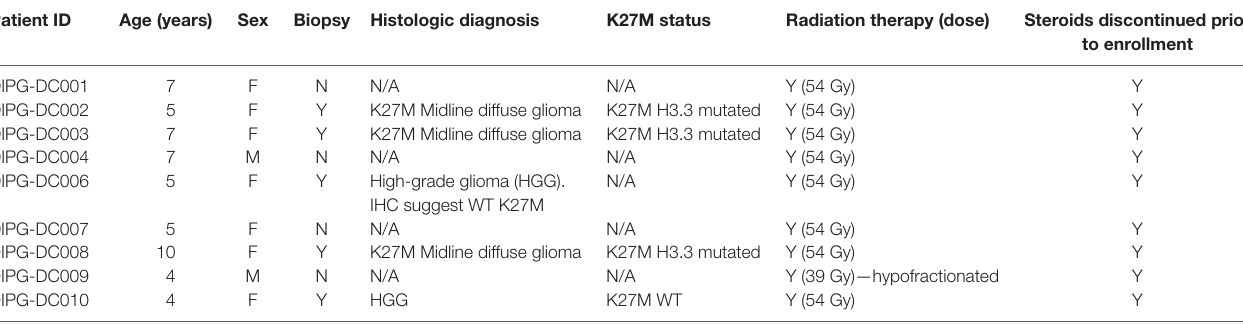
TaBlE 1 | Patients